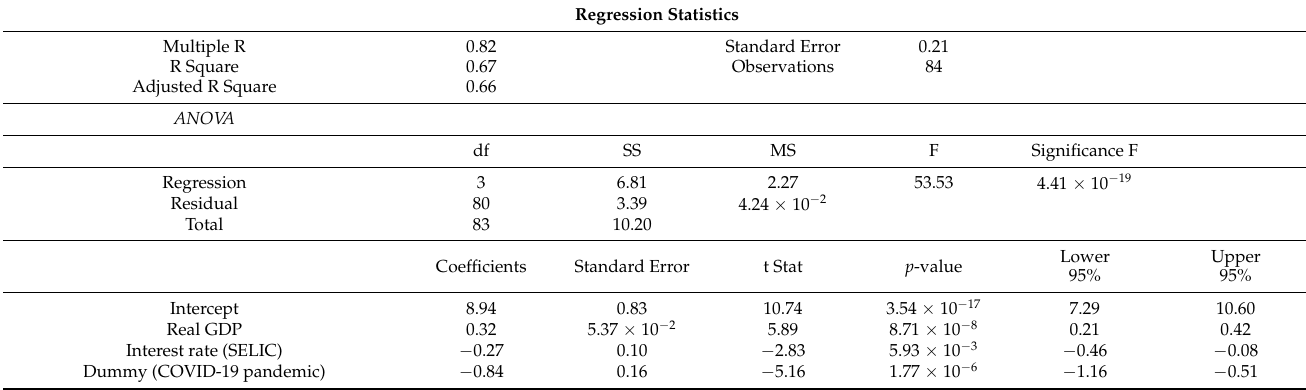
Table A2. Regression statistics, ANOVA table, and coefficient statistics for the conventional model, without considering shared economy in the transportation